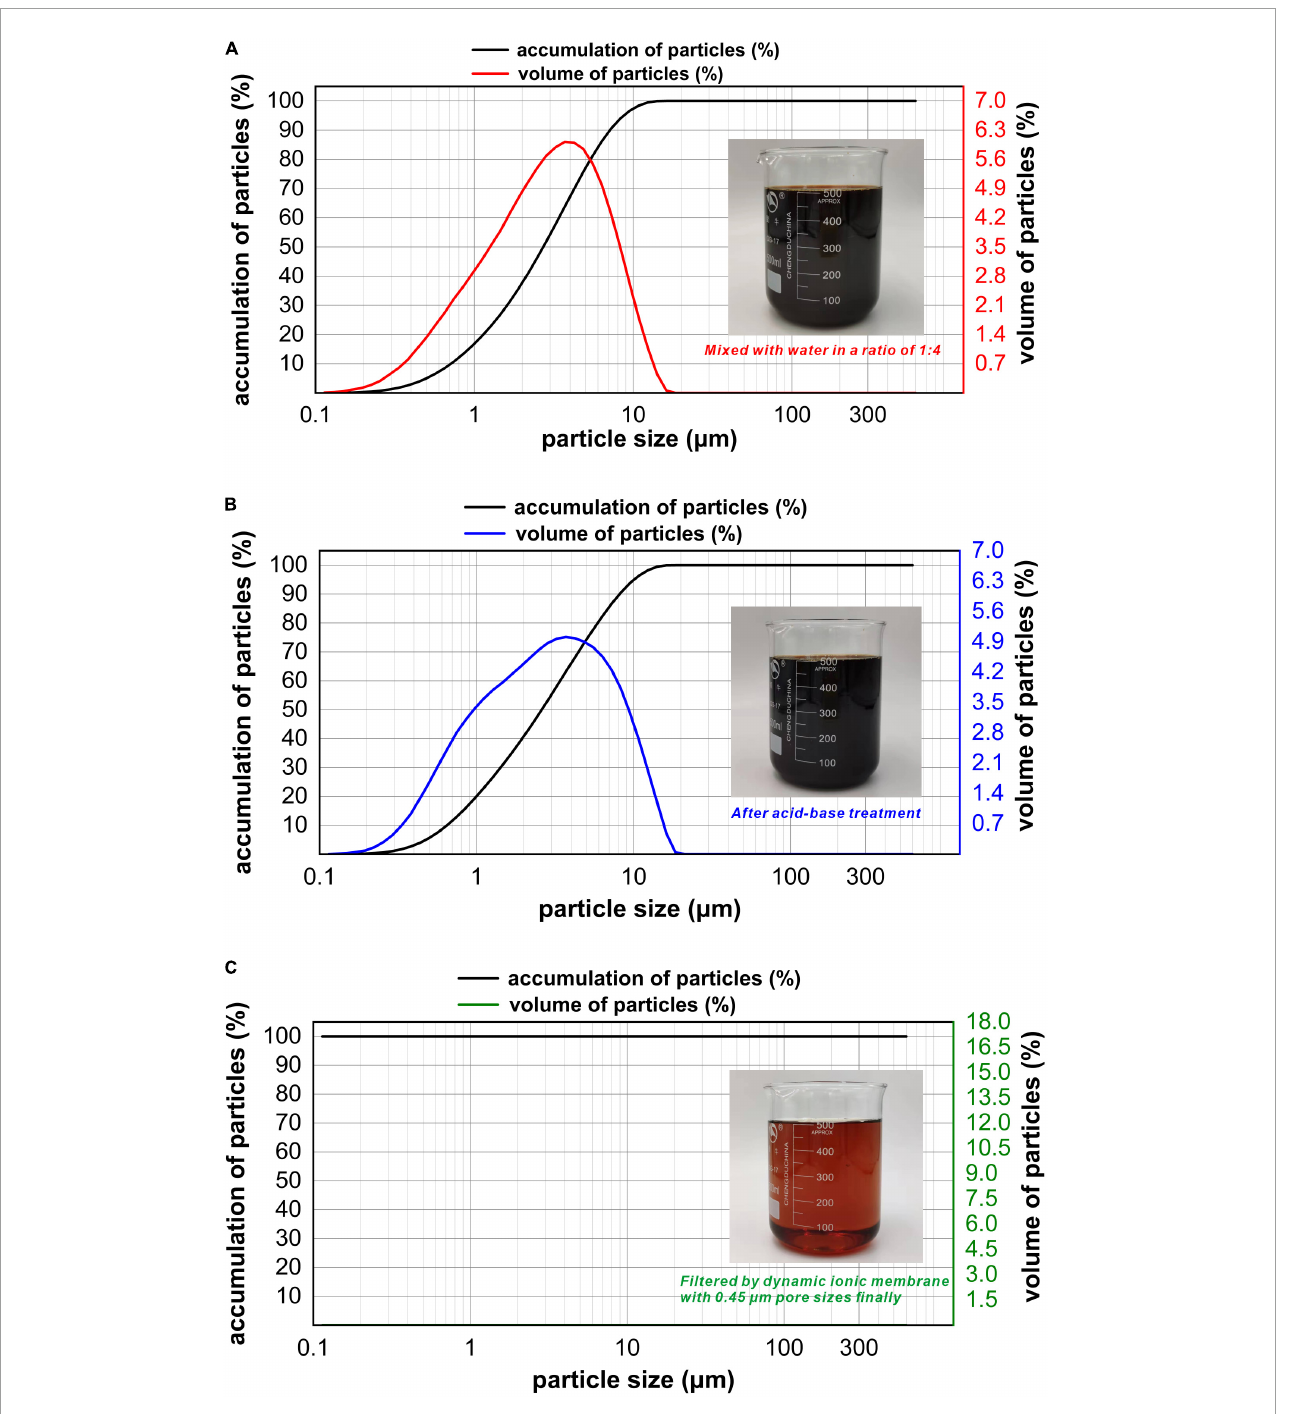
FIGURE2 Particle size distribution plots for the refinery final molasses with different treatments. The measurement range is 0.02-2,000 µ m, with water as the dispersion medium, injector model: Hydro 2000 MU (A), wet injection. When the laser irradiates the fine sample particles, scattering will occur, and the particle size distribution of the sample particles can be obtained using the relationship between the scattered light intensity and the number of particles of the corresponding particle size. The abscissa in the figure is the particle size of the particles in the solution, the abscissa is the partial size ( µ m), and the two ordinates are the accumulation of particles and volume of particles. (A) Particle size of the refinery final molasses diluted with water 1:4 and shown in a distribution diagram. (B) Particle size distribution diagram of refinery final molasses after acid-base treatment. (C) Particle size distribution diagram of refinery final molasses filtered with 3, 1, and 0.45 µ m nuclear pore membrane in